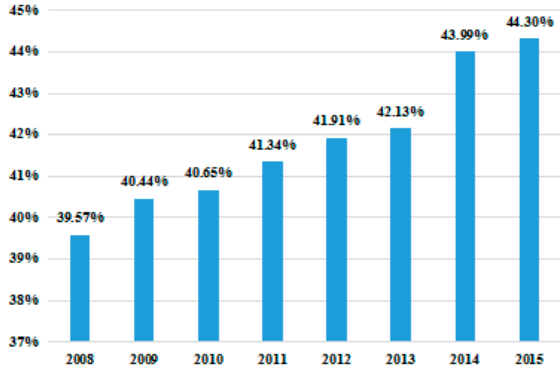
Figure 3. Average thermal efficiency of power plants in China (2008–2015).